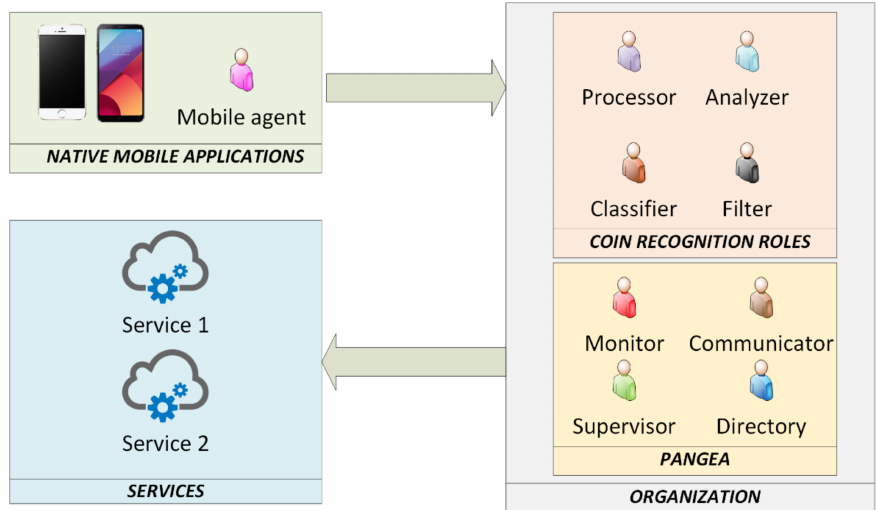
Figure 1. Roles of the virtual organisation of